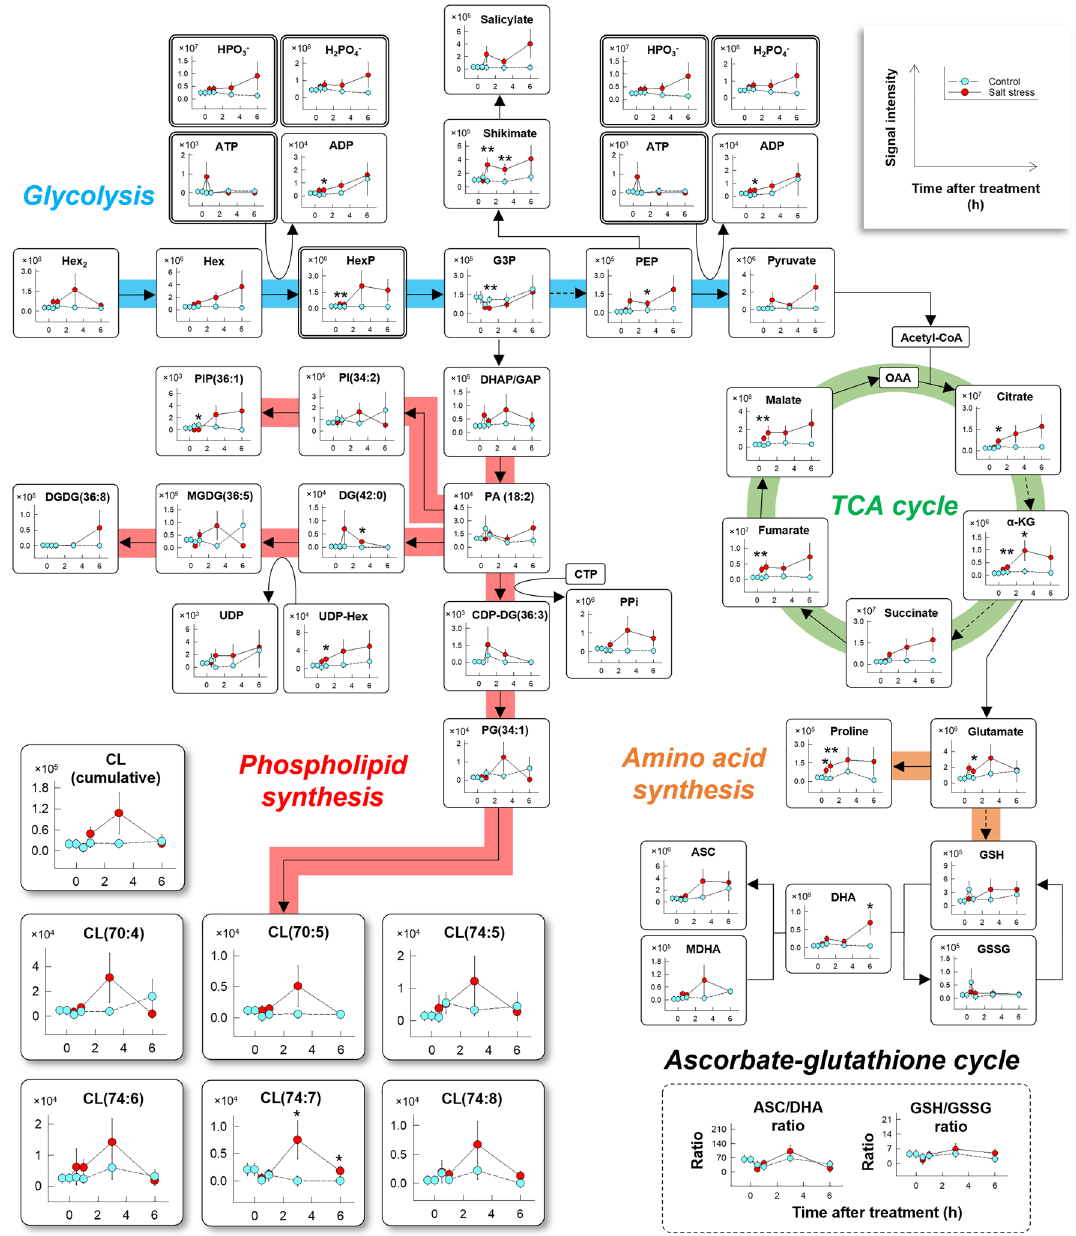
Figure 2. Metabolic network altered in the stalk cells under salt stress conditions. The signal intensity in picoPPESI negative ion mode mass spectra plotted against the time after treatment (h). Ascorbate (ASC)/ dehydroascorbate (DHA) and glutathione (GSH)/oxidized glutathione (GSSG) ratios calculated are also shown. Cyan and red plots indicate control and salt stress treatment, respectively. Data are means ± SE for 8–32 stalk cells from 3 to 6 plants in each treatment. The p -value at the 0.1 and 0.05 probability levels indicated with * and **, determined using t- test. Hex: hexose; HexP: hexose phosphate; ATP: adenosine 5’-triphosphate; ADP: adenosine 5’-diphosphate; G3P: glycerol-3-phosphate; DHAP: dihydroxyacetone phosphate; GAP: glyceraldehyde 3-phosphate; PEP: phosphoenolpyruvate; α-KG: α- ketoglutarate; OAA: oxaloacetate; MDHA: monodehydroascorbic acid; PA: phosphatidic acid; DG: diacylglycerol; UDP: uridine 5’-diphosphate; MGDG: monogalactosyl diacylglycerol; DGDG: digalactosyl diacylglycerol; CTP: cytidine triphosphate; PPi: bisphosphate; CDP-DG: cytidine diphosphate diacylglycerol; PI: phosphatidylinositol; PIP: phosphatidylinositol monophosphate; PG: phosphatidylglycerol; CL: cardiolipin. Line graphs were created with Sigmaplot